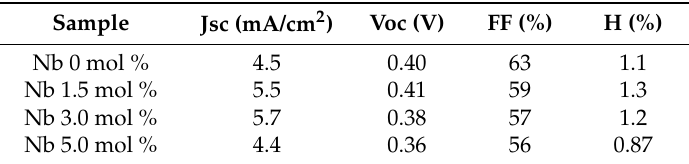
Figure 4. ( a ) Photocurrent-density–voltage curves and ( b ) incident photon-to-current conversion efficiency spectra of Interfacial charge-transfer (ICT) photoconversion devices based on the undoped and Nb-doped TiO 2 electrodes prepared in this study. Table 2. Photovoltaic-performance parameters of Interfacial charge-transfer (ICT) photoconversion devices based on the undoped and Nb-doped TiO 2 electrodes prepared in this study.